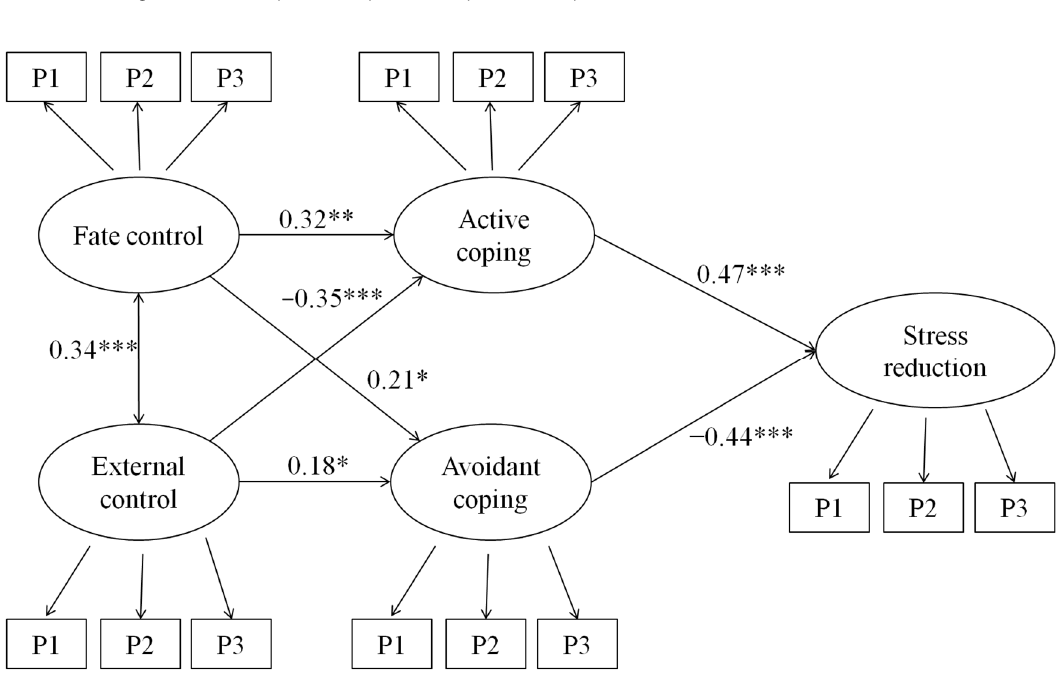
FATC = fate control; ELOC = external control; STR = perceived stress; CTRL = perceived controllability; ACT = active coping; AV = avoidant coping; SR = stress reduction. The scores of ACT, AV and SR were averaged across the eight scenarios. † p < 0.10, * p < 0.05, ** p < 0.01, *** p < 0.001.